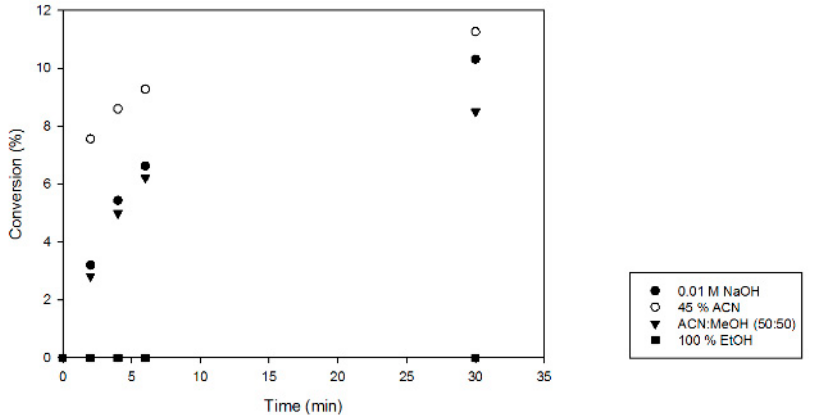
Figure 2. Evaluation of enzyme inactivation methods. Reaction mixtures (2 mM GDP-Man, 0.01 mg/mL MfGM35E, pH 8) were incubated at 37 °C. At defined time points, samples were 10× diluted in various inactivation solutions (0.01 M NaOH, 45% acetonitrile (ACN), acetonitrile/methanol (MeOH) (50:50), or 100% ethanol (EtOH)). The y-axis represents the conversion of GDP-Man towards GDP-L-Gal.